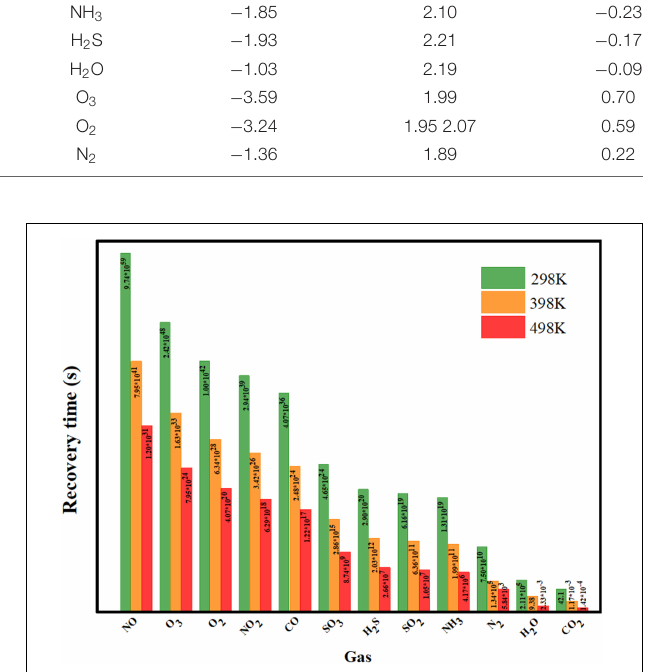
FIGURE 6 | Recovery time for the Gas@PtN 3 -CNT systems at various temperatures.